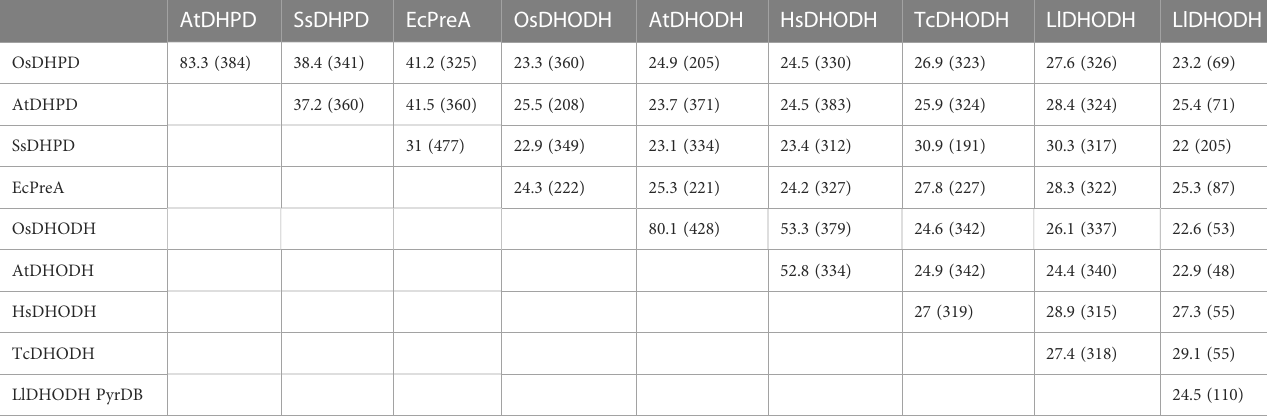
TABLE 1 Percent identities in pairwise amino acid sequence alignments of DHPDs and DHODHs from different